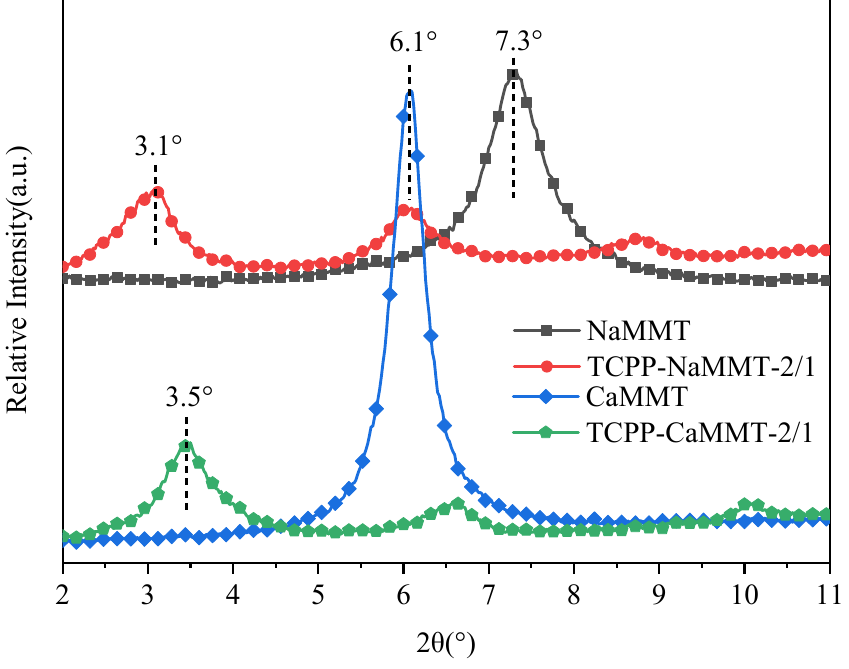
Figure 5. XRD pattern of TCPP/NaMMT and TCPP/CaMMT.